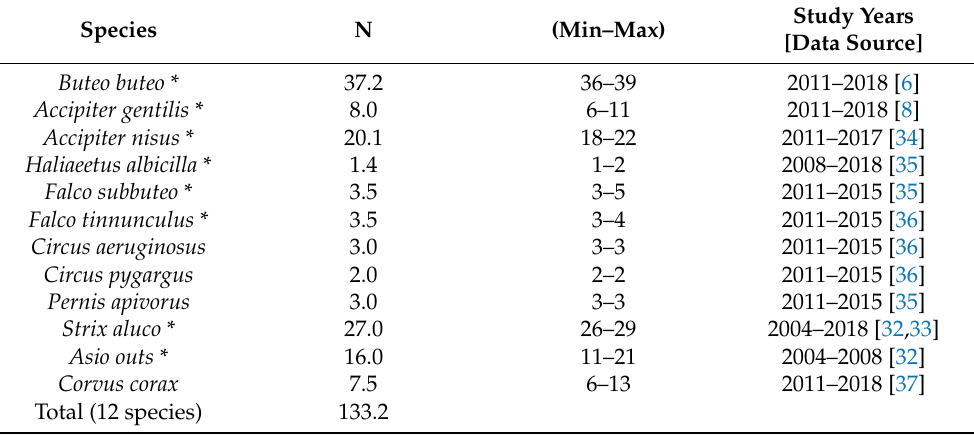
Table 1. The mean number of breeding pairs of avian predators in the breeding season in the area of study (central Poland, vicinity of Rogów village, Experimental Forest Station of Warsaw University of Life Sciences). * Species that were included in the food niche overlap analysis presented in this paper are marked with an asterisk. The source of the abundance data is given in brackets.